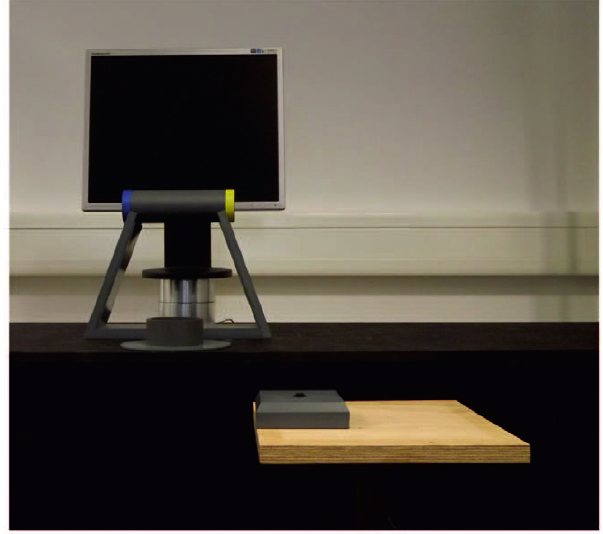
Figure 1. Front view of the experimental set-up.